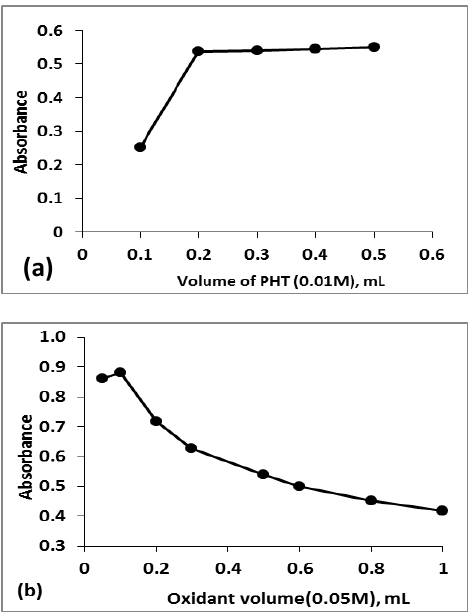
Figure 5. (a) Effect of volume of PHT, (b) Effect of volume of oxidant.